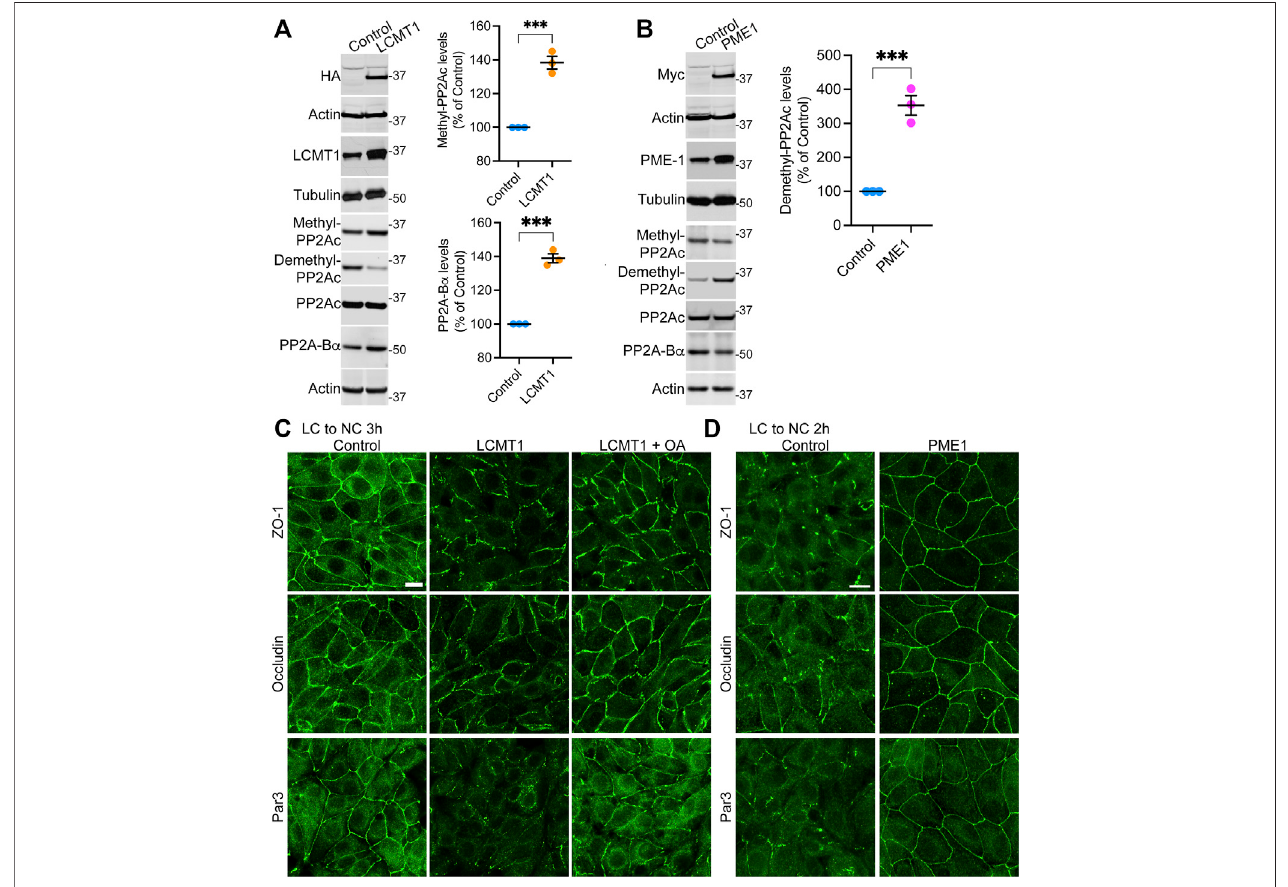
FIGURE1| OverexpressionofLCMT1andPME1inMDCKcellsaffectstheinitialredistributionofZO-1,occludinandPar3tocell-cellcontactsduringCa 2+ -induced TJ reassembly. (A) Total lysates from MDCK-LCMT1 and control MDCK cells were analyzed by Western blot (left) for HA-LCMT1, LCMT1, PP2A-B α , and total/ methylated/demethylated PP2Ac levels. Relative expression levels (right) of PP2A-B α and methylated PP2Ac were quanti fi ed in these cells (mean ± SEM; n = 3; Student ’ s t -test; *** p < 0.001). (B) Representative immunoblots of myc-PME1, PME1, PP2A-B α , and total/methylated/demethylated PP2Ac levels in total lysates from MDCK-PME1 and control MDCK cells (left). The relative levels of demethylated PP2Ac (mean ± SEM; n = 3; Student ’ s t -test; *** p < 0.001) were quanti fi ed in these cells(right). (C) DistributionofZO-1,occludinandPar3incontrolMDCKandMDCK-LCMT1cells3 hafteraCa 2+ switch.AsubsetofMDCK-LCMT1cellswasincubated with 100 nM OA (+OA) during the switch. (D) Distribution of ZO-1, occludin and Par3 in control MDCK and MDCK-PME1 cells switched for 2 h from LC to NC medium. For (C – D) , representative images from three separate experiments are shown. Scale bars = 10 μ